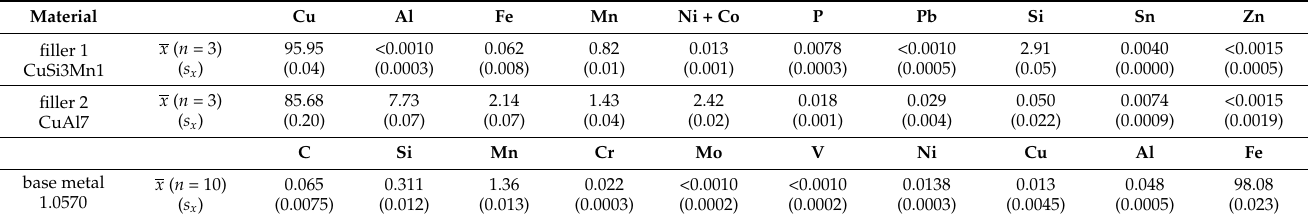
Table 1. Chemical compositions of used materials, in wt%.